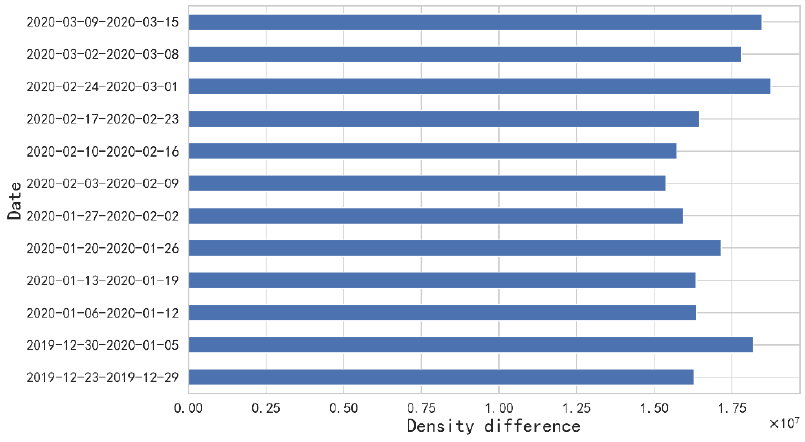
( p ) Figure 14. Influence of density difference on the improvements of ELV compared with other meth- ods on two indicators, namely: improvement on SC compared with ( a ) DBSCAN 200, ( b ) DBSCAN